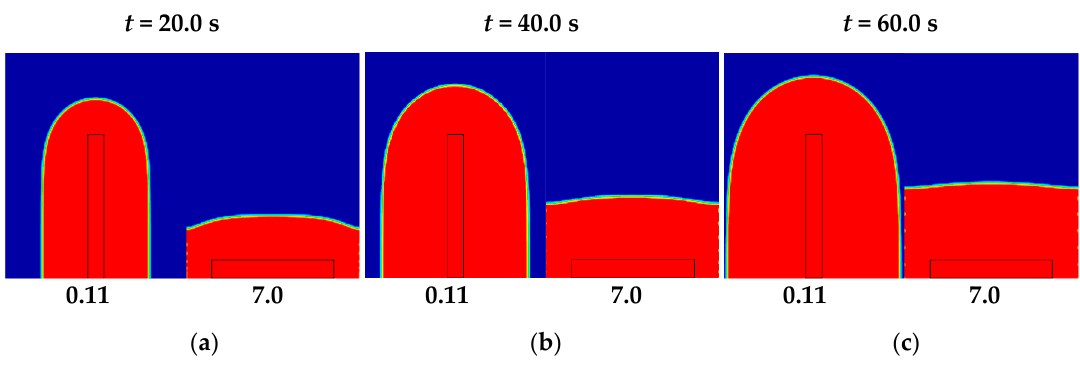
Figure 8. Resin volume fraction for ϕ = 0.1 and two different ratios of L 0 / H 0 : ( L 0 / H 0 ) o = 0.11 (optimal), L 0 / H 0 = 7.0 (worst scenario) as a function of time: ( a ) t = 20.0 s, ( b ) t = 40.0 s, ( c ) t = 60.0 s.